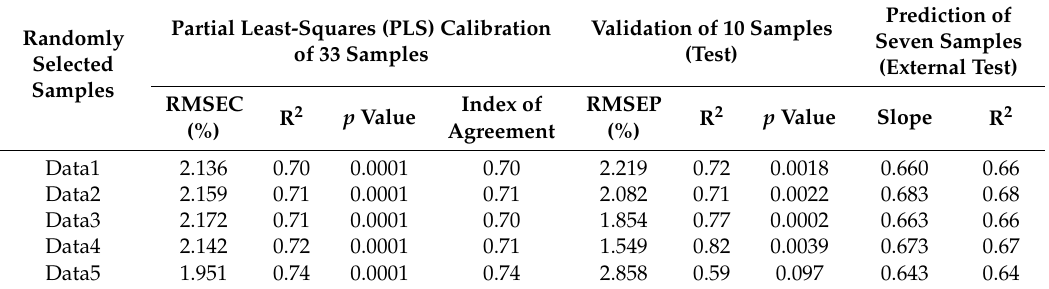
Table 3. Statistical parameters obtained for different randomly selected data sets. Forty-three samples of the selected reflectance-based model were used.